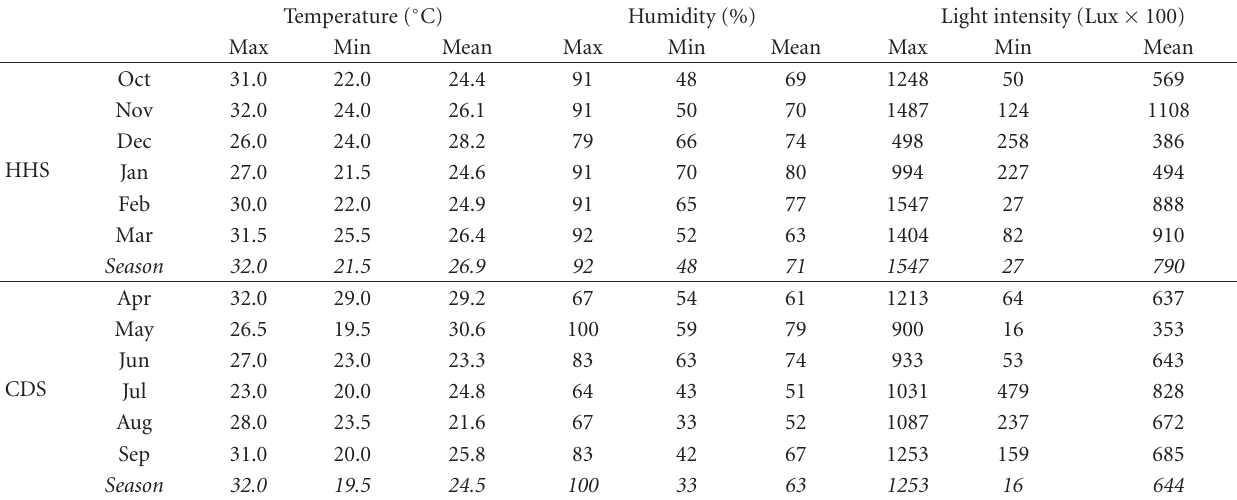
Table 3: Weather conditions recorded throughout the year for the foraging study in the social wasp Polybia paulista . Maximum (max) and minimum (min) absolute values and mean values of temperature ( ◦ C), relative humidity (%), and light intensity (lux × 100) for each month and the entire season. HHS: hot and humid season. CDS: cold and dry season.